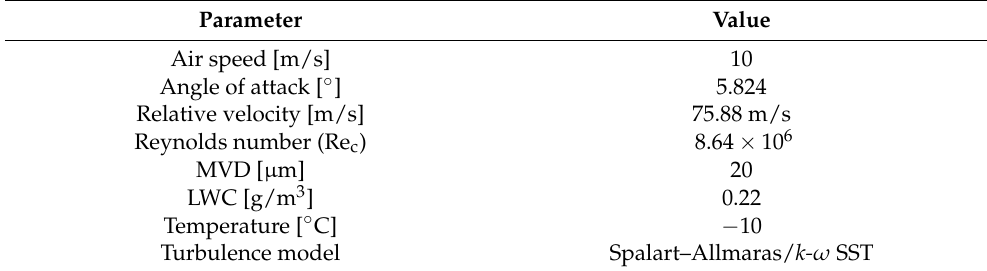
Table 1. Simulation parameters.